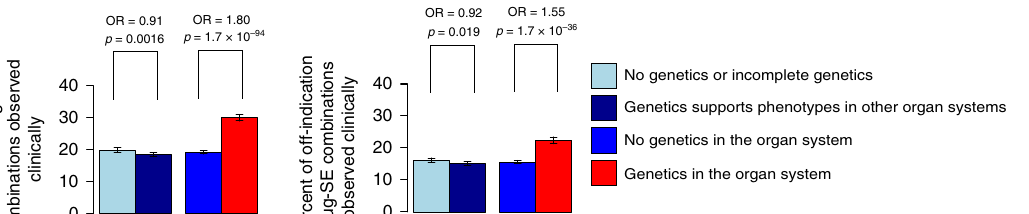
Fig. 1 Data sources and analysis work fl